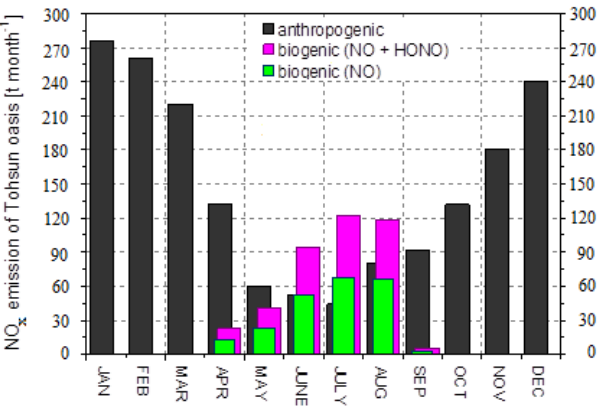
Figure 8. Anthropogenic NO x emissions vs. soil biogenic from NO and HONO emissions of the Tohsun Oasis in 2010; biogenic emis- sions of nitrous acid (HONO) have been estimated according to Os- wald et al. (2013). All data are given in terms of mass of